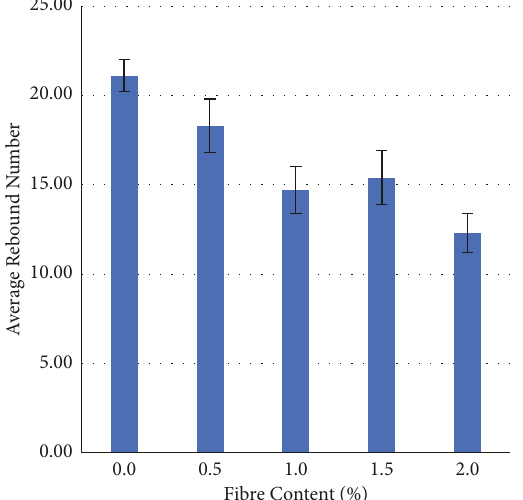
Figure 2: Average rebound number for FRCC with PET fibre